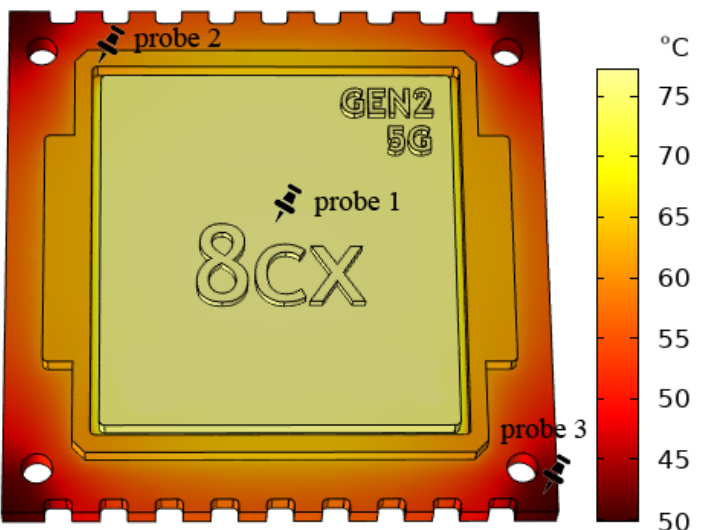
Figure 4. Thermal distribution on the CPU inside the FTU (contains the locations of three probes).